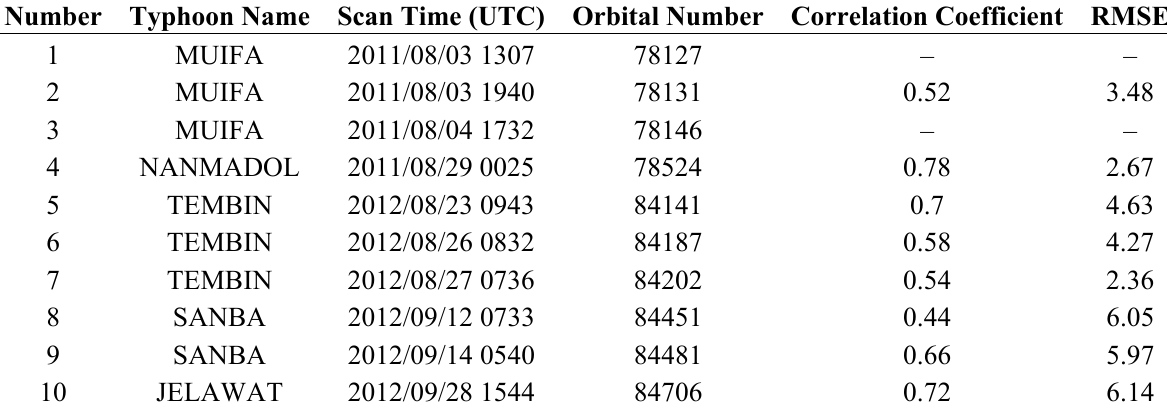
Table 4. RR validation